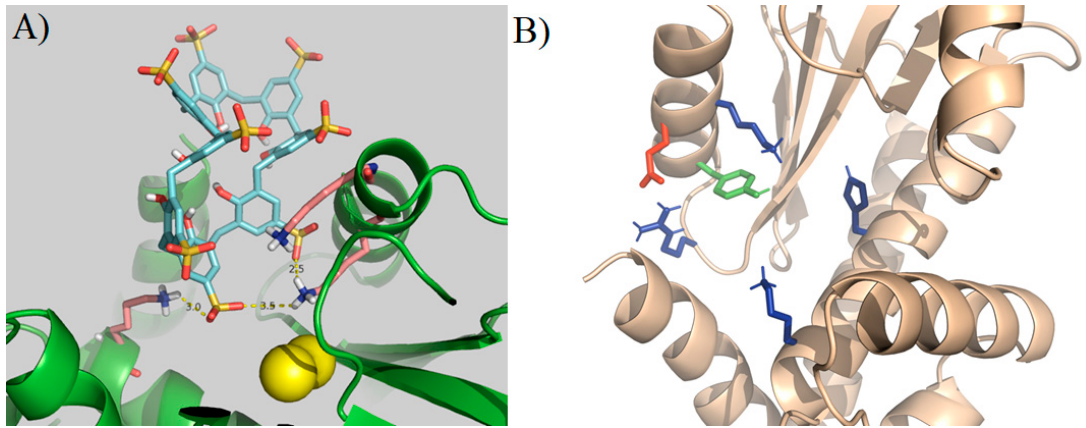
Figure 7. Blind docking results for top pose obtained; ( A ) cartoon representation of H3N2 endonuclease DNA binding site and ( B ) main interacting residues around the active site for the top SC8a pose are depicted in stick format. Color codes are specified in Table 2.